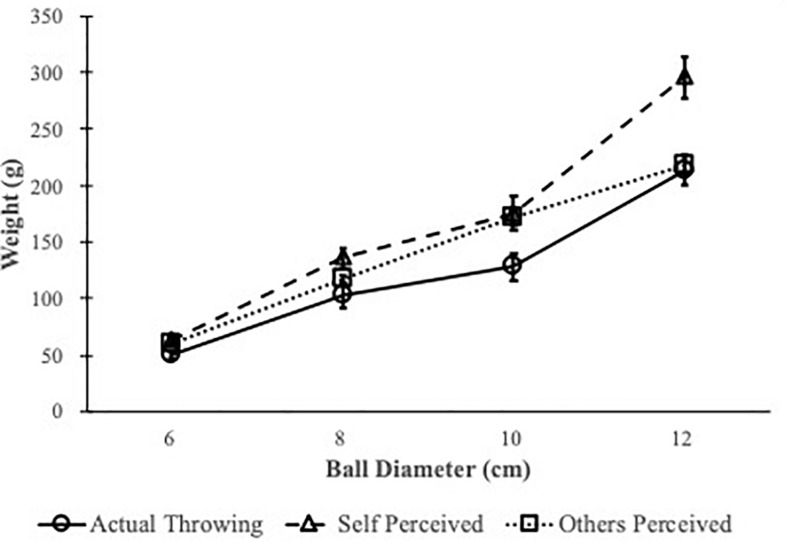
Sizes and weights of the most throwable balls for the confederates, as thrown by themselves (circle), as ranked by themselves (triangle), and as ranked by the participants (square). Error bar = 1 SE.